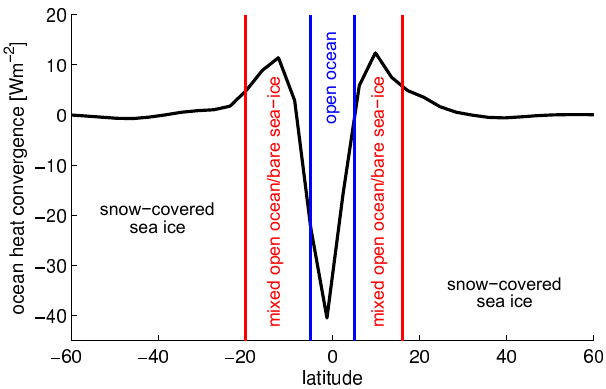
Fig.10. Convergenceofoceanheattransportforthe4ppm CO 2 simulationwithlowbaresea-icealbedo Fig. 10. Convergence of ocean heat transport for the 4ppm CO 2 anddisabledsea-icedynamics. Thesimulationequilibratesat85 % sea-icecover. Thebluelinesseparate simulation with low bare sea-ice albedo and disabled sea-ice dy- the year-round open ocean area from areas with seasonal bare sea ice. The red lines indicate the border betweenareaswithseasonalbareseaiceandareaswithyear-roundsnow-coveredseaice(cf. Fig.9left). namics. The simulation equilibrates at 85% sea-ice cover. The blue lines separate the year-round open ocean area from areas with sea- sonal bare sea ice. The red lines indicate the border between areas with seasonal bare sea ice and areas with year-round snow-covered 35 sea ice (cf. Fig.9